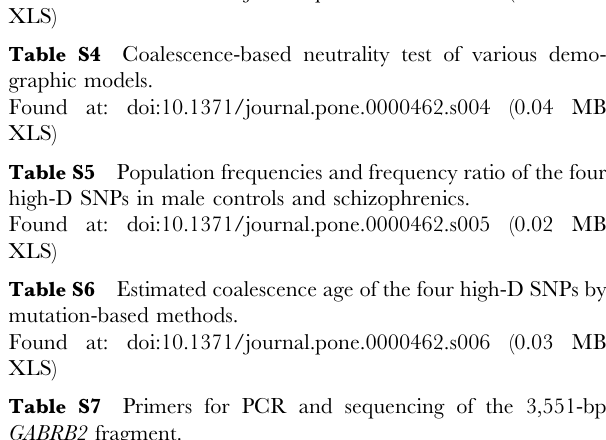
Table S3 Compositions and population frequencies of 75 inferred haplotypes.